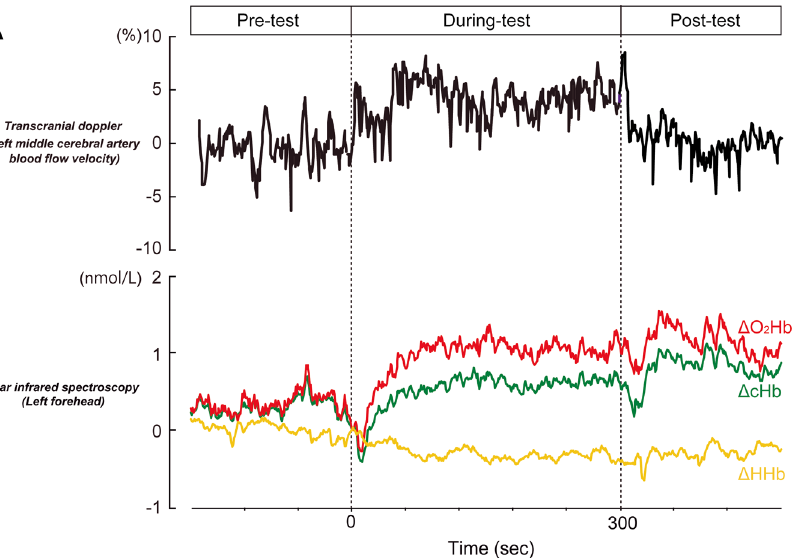
Figure 2. The cerebral hemodynamic changes, associated with TO-gum chewing, simultaneously measured by Transcranial Doppler Ultrasound (TCD) (A) and near infrared spectroscopy (NIRS) (B). Both hemodynamic signals were measured from the left hemisphere. In (A), middle cerebral artery blood flow velocity (MCAV) is shown. In (B), oxygenated hemoglobin ( D O 2 Hb) is represented by a red line, deoxygenated hemoglobin ( D HHb) by a yellow line, and total hemoglobin ( D cHb) by a green line.